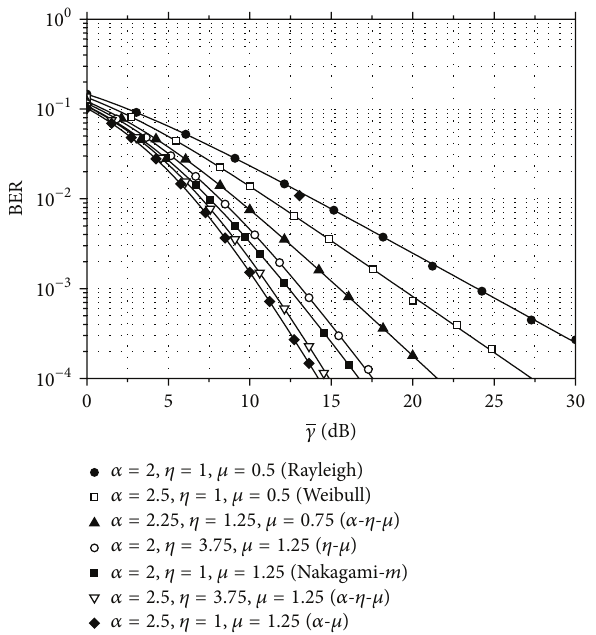
Figure 10: Average error probability for BPSK with 𝛼 - 𝜂 - 𝜇 fading.